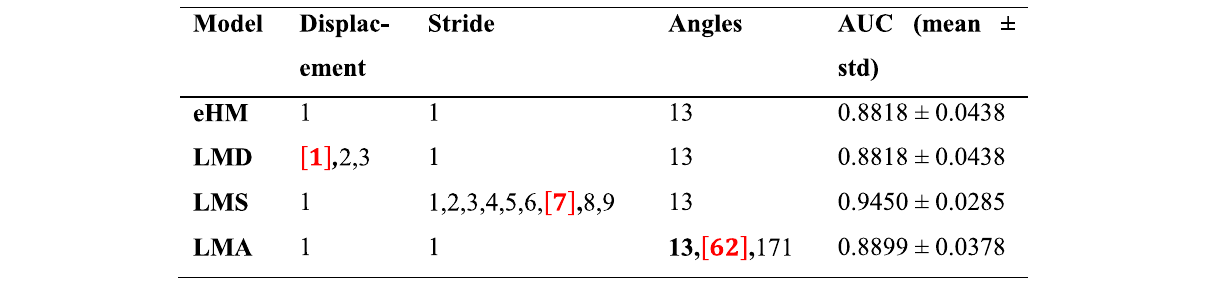
The red number in square brackets represents the parameter for the OCR. AUC Area under the curve of receiver operating characteristic curve; OCR Optimized classification results, eHM : Extended Haralick measure, LMD Learning model by multiple displacements, LMS Learning model by multiple strides, LMA Learning model by multiple